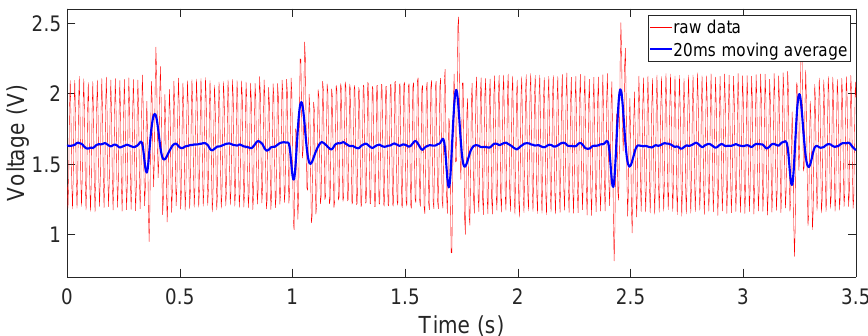
Figure 8. Contact ECG outputs on ( a ) hand and ( b ) chest.